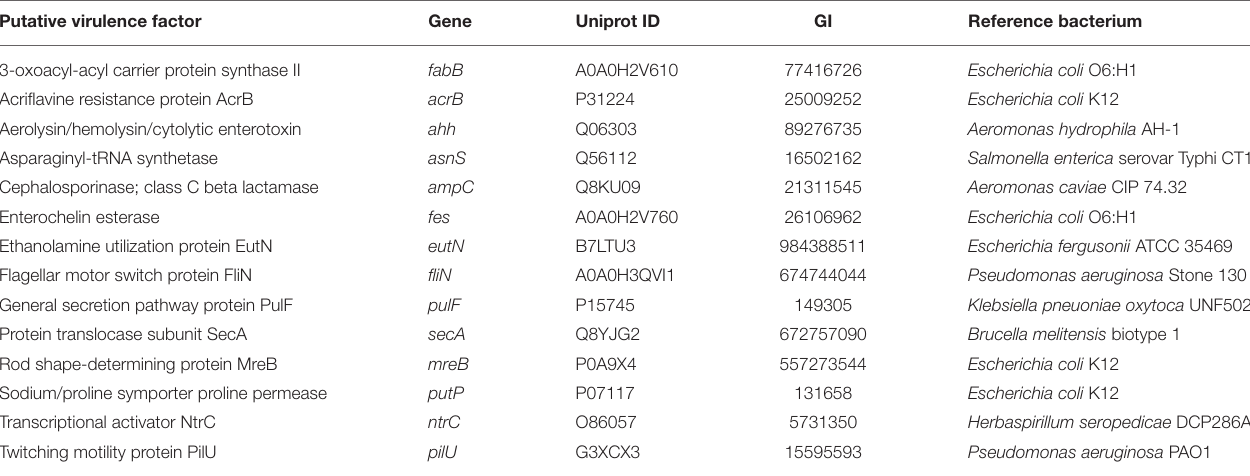
TABLE 3 | Predicted virulence factors that are conserved within vAh strains (not unique to), based on a comparison of significant BLASTn hits between vAh isolates against the VFDB (virulence factors with additional results are marked with an asterisk and are available in supplementary data). Putative virulence factor